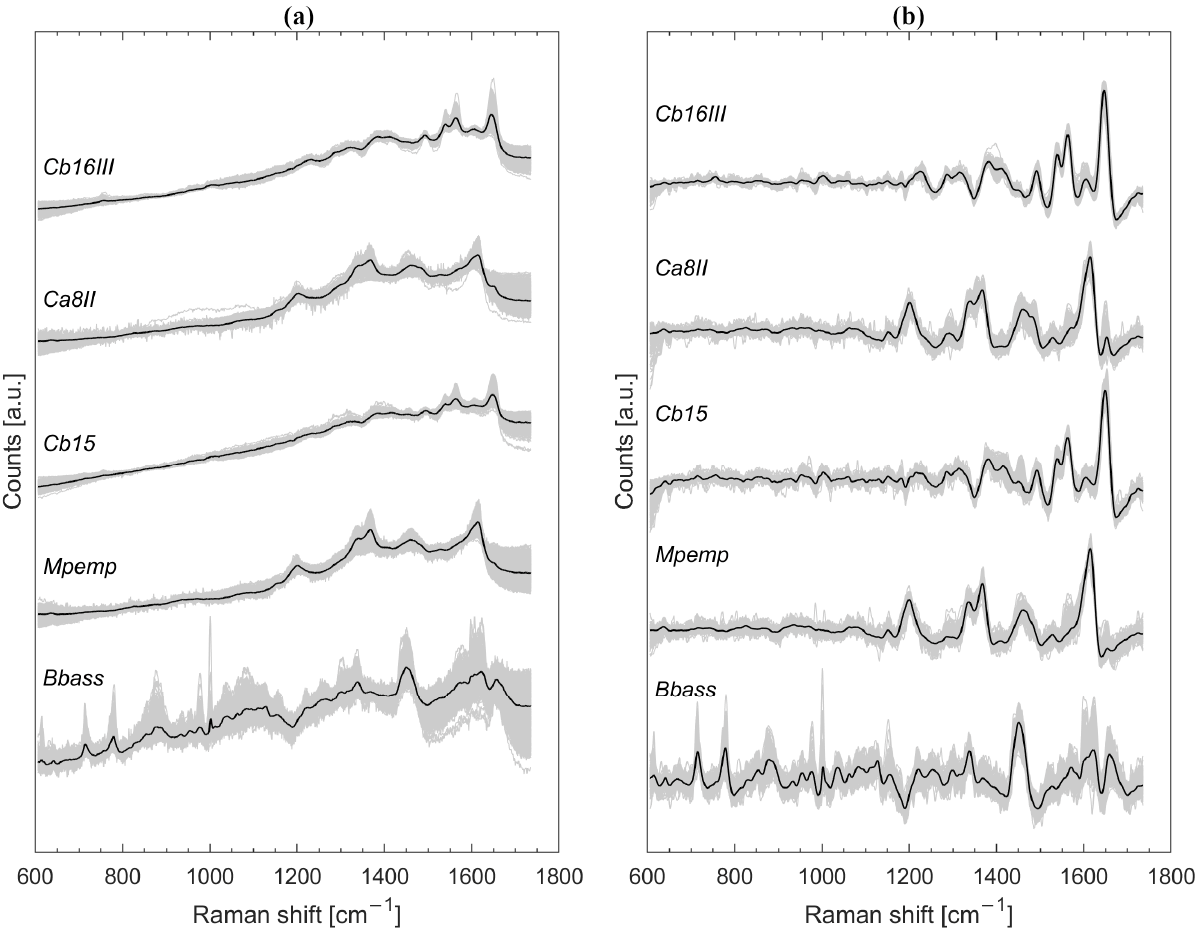
Figure 1. All Raman spectra of the fungal spores in grey and arithmetic mean spectra highlighted in black (displayed with a Y ‐ axis offset). Untreated ‐ but ‐ normalized Raman spectra ( a ) and preprocessed spectra (baseline subtraction, smoothing, z ‐ score normalization) ( b ).